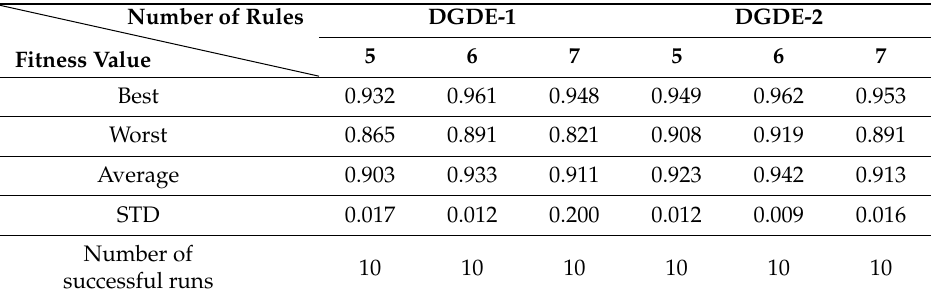
Table 2. Performance evaluation of different fuzzy rule numbers. STD: standard deviation.